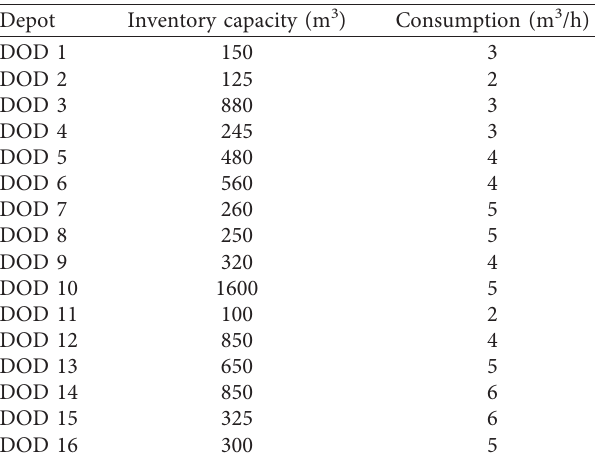
Figure 4: Diagram of POL supply chain network in theater. Table 1: Simulation assumption